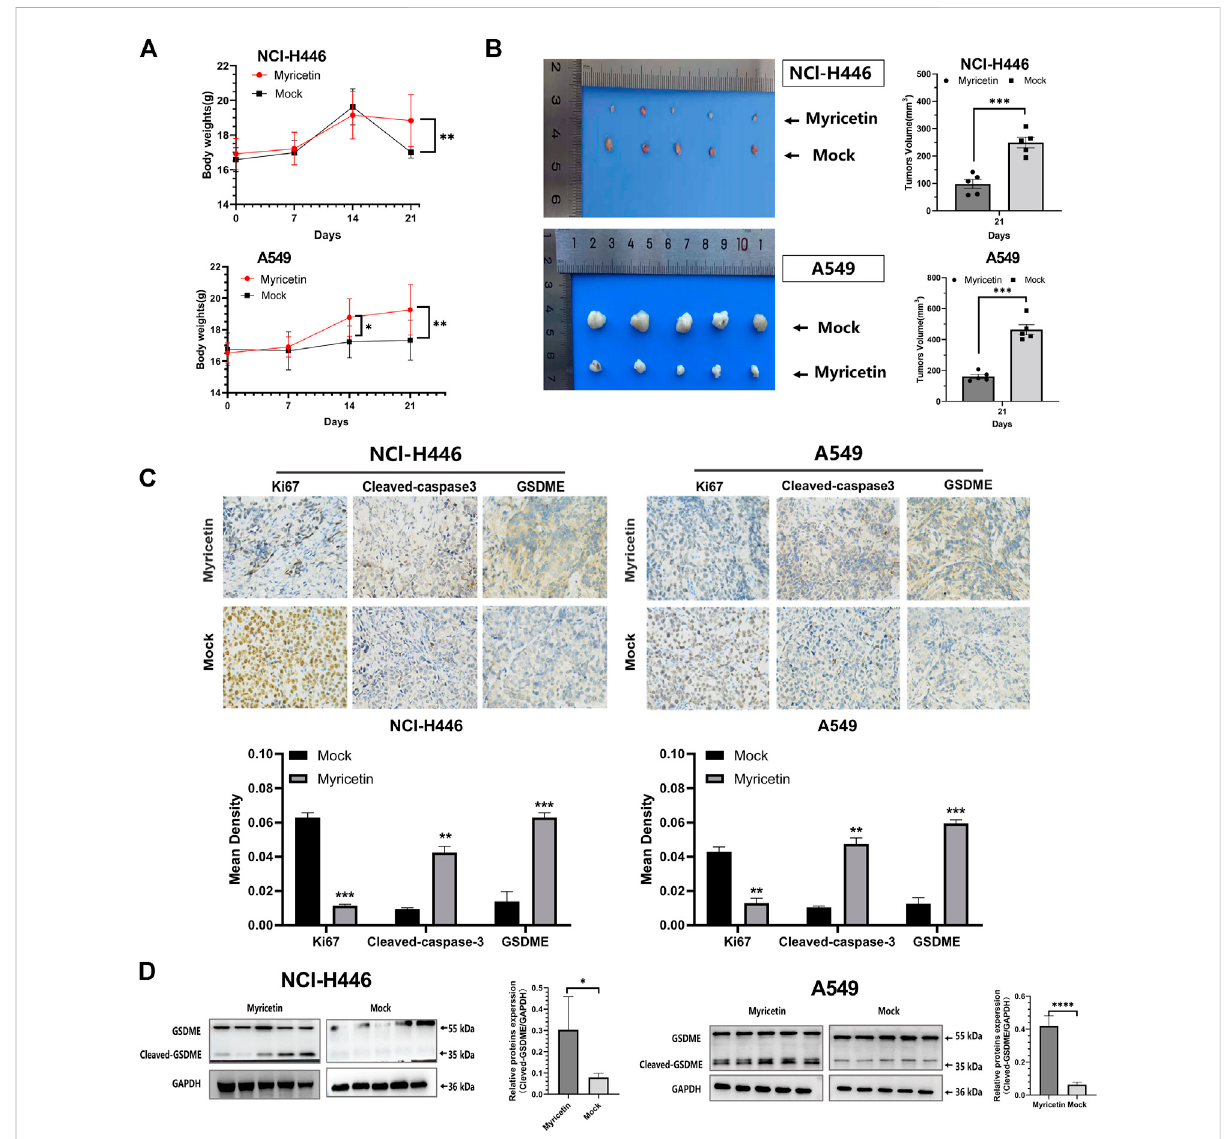
Theantitumoreffect ofmyricetin invivo . Myricetin wasintratumorallyinjectedto themiceevery 2 days for 2 weeks.Body weight (A) , images of xenografted tumors (B) , and tumor volumes (B) were recorded. (C) Analysis of Ki67 and immunohistochemistry (cleaved-caspase-3 and GSDME) results from tumor samples. (D) Western blot analyses of GSDME from tumor samples and its corresponding statistical analysis. The results were presented as mean ± standard deviation (** p < 0.01, *** p < 0.001, when compared with the